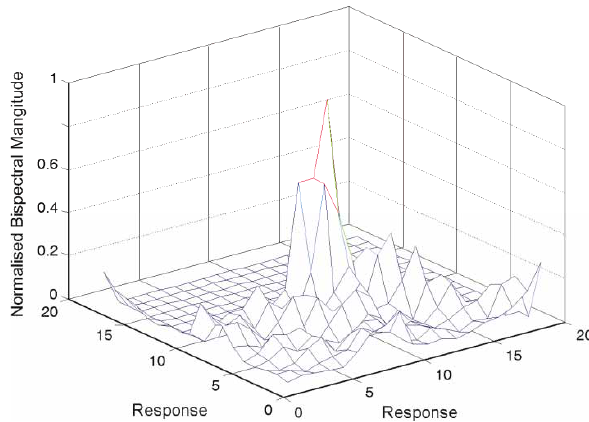
Fig. 10. Bispectrum of methods to encourage the implementa- tion of waste management